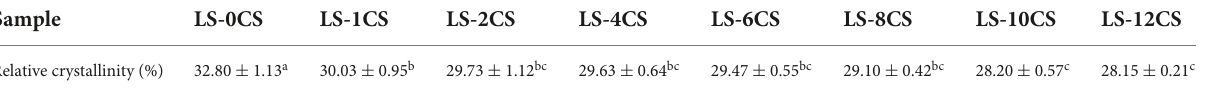
TABLE 1 Relative crystallinity levels of lotus seed cross-linked resistant starch samples.